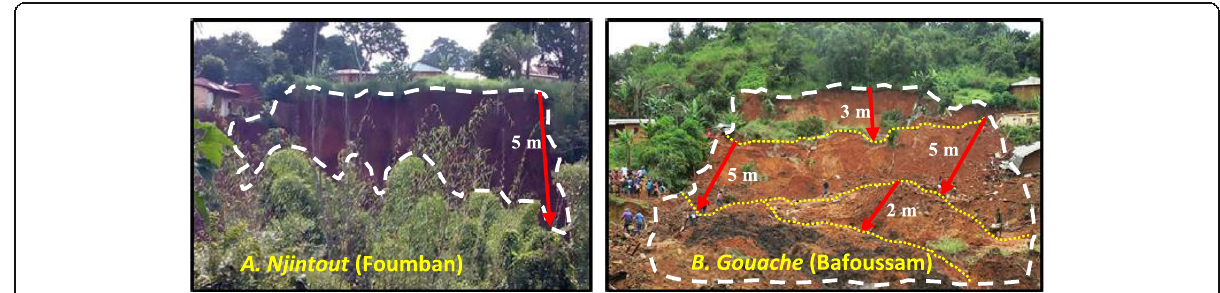
Fig. 2 Unscaled partial views of the scarps leaved by landslides of Foumban (in 2018) and Bafoussam (in 2019) – Both events were sudden with transitional to rotational movements, but the one in Foumban happened in one step, while the one in Bafoussam happened in three steps (yellow dashed), justifying three main blocks/stairs. Based on the soil horizontal surface, the sliding depths (arrows) are 5 m in Foumban, and 1 to 5 m in Bafoussam. The affected area was ≈ 30,100 m 2 in Foumban (IGMR-Penaye et al., 2018) and ≈ 15,051 m 2 in Bafoussam (IGMR-Kankeu